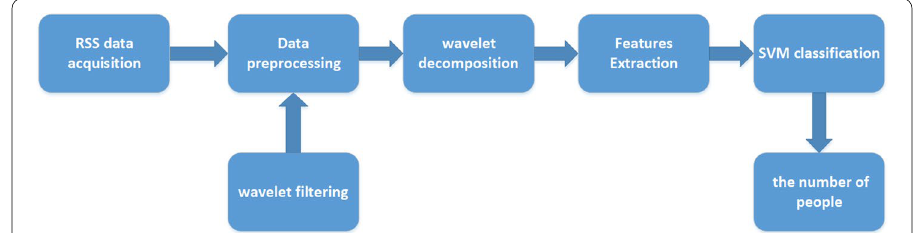
Fig. 1 The basic block diagram of the proposed system